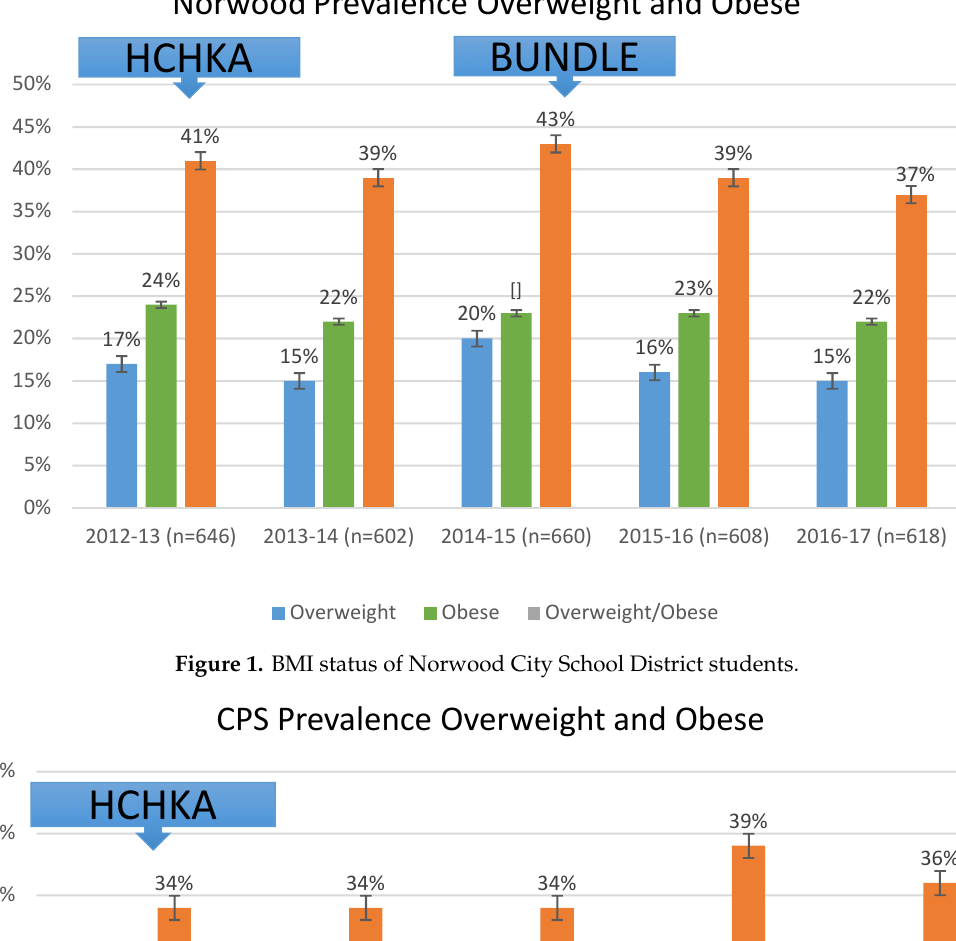
Figure 1. BMI status of Norwood City School District students.